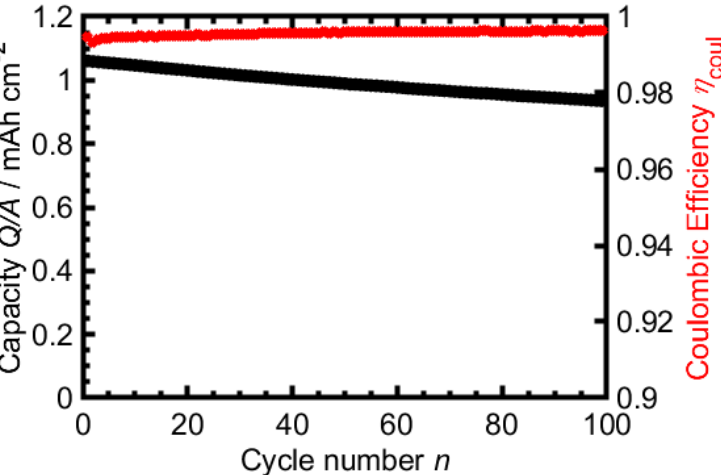
Figure 2. Cycling performance of a graphite/NCM cell with 1 M LiTFSI in TBAC:EC:EMC:DEC (60:15:5:20 wt) electrolyte at T = 25 ◦ C. The cell was charged and discharged at C−rate C